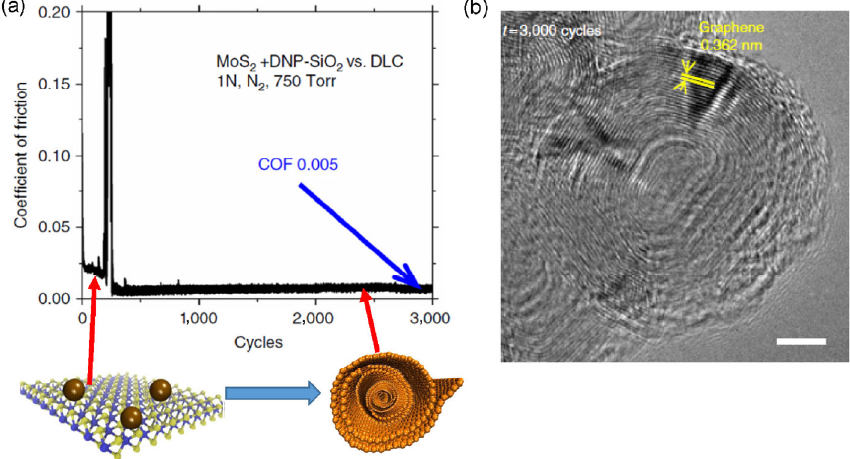
Fig. 5 Macroscale superlubricity achieved by onion-like carbon formation. (a) Coefficient of friction during sliding of MoS 2 combined with nanodiamonds against DLC surface reaches ultralow friction values ( ∼ 0.005), (b) observed superlubricity is attributed to the formation of onion-like carbon films, as observed in TEM images. Reproduced with permission from Ref. [44]. © Springer Nature,